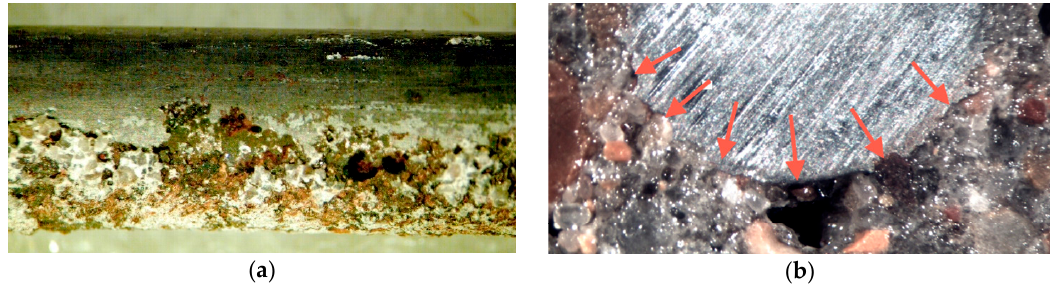
Figure 2. ( a ) One side of a steel bar (6 mm diameter) with no corrosion evident at the top but pitting is evident along the lower side, ( b ) cross-section of concrete and 6 mm diameter steel bar, with the arrows indicating voids in the concrete and associated localized (pitting) corrosion. © R.E. Melchers 2020.